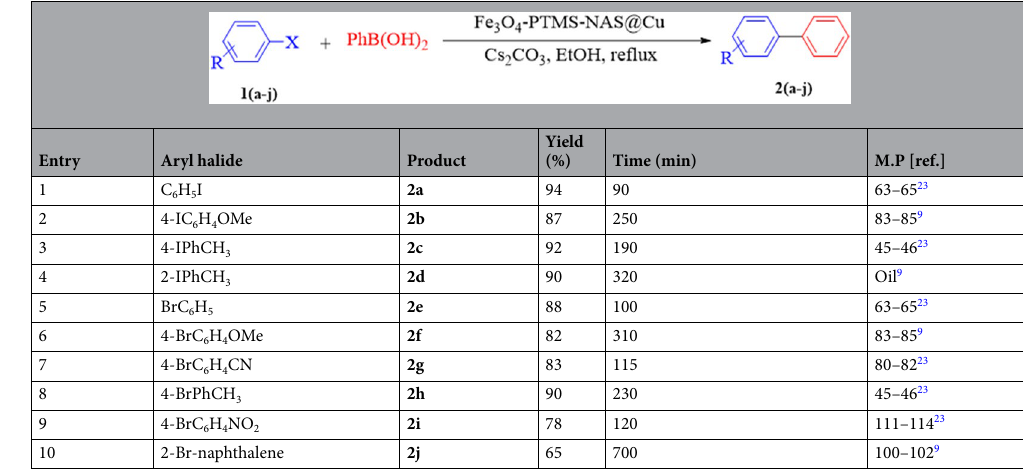
Table 2. Synthesis of biphenyl derivatives by Suzuki reaction in presence of Fe 3 O 4 -PTMS-NAS@Cu MNPs. Reaction conditions: Aryl halide (1 mmol), phenylboronic acid (1 mmol), CS 2 CO 3 (1 mmol), Fe 3 O 4 -PTMS-